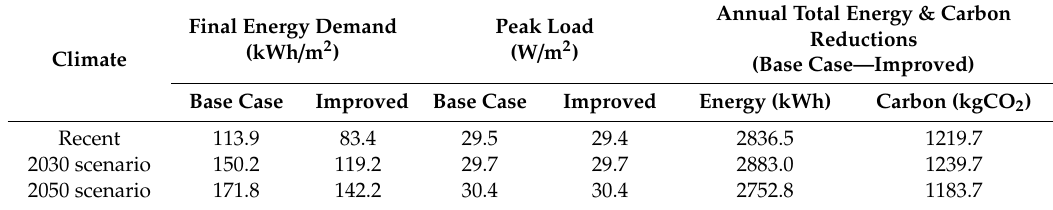
Table 9. Energy performances of the building as-built and with improvement strategies (see text above).